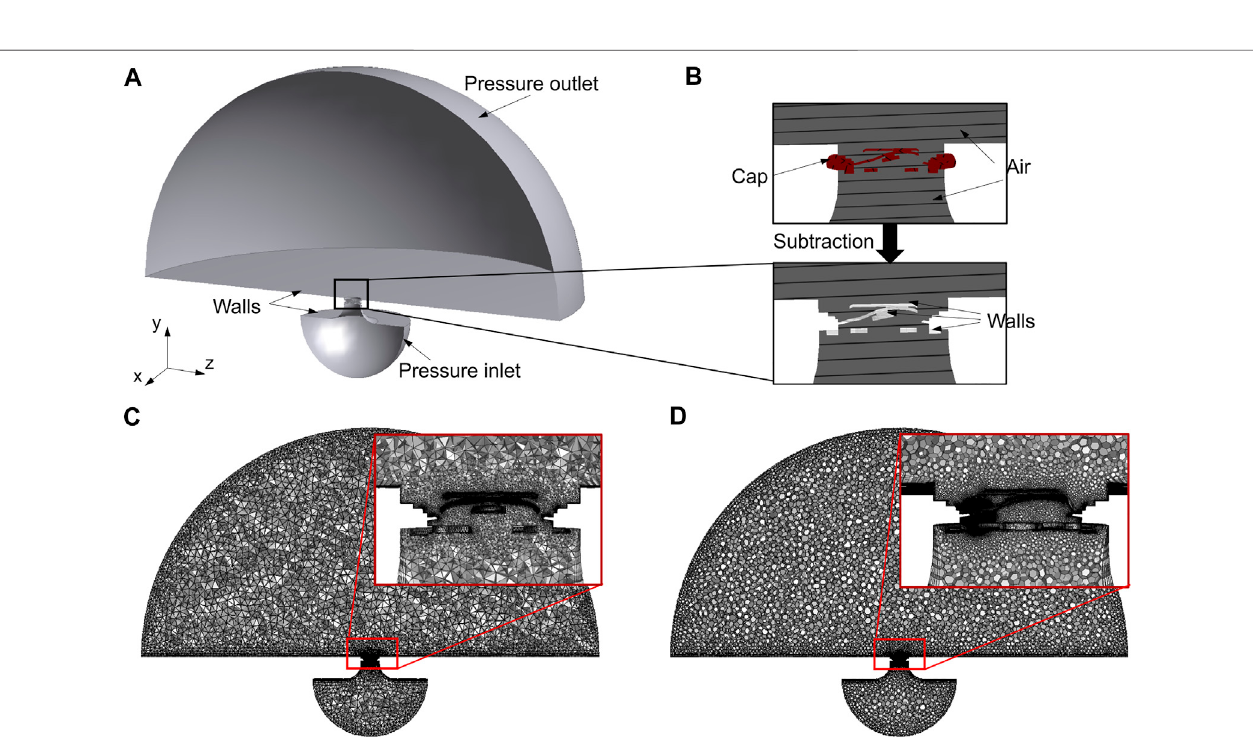
FIGURE 1 | Detailed 3-D geometric model with vent cap assembly components listed for the: MTI cap (A) , LG MJ1 cap (B) , K2 cap (C) , and LG M36 cap (D) .